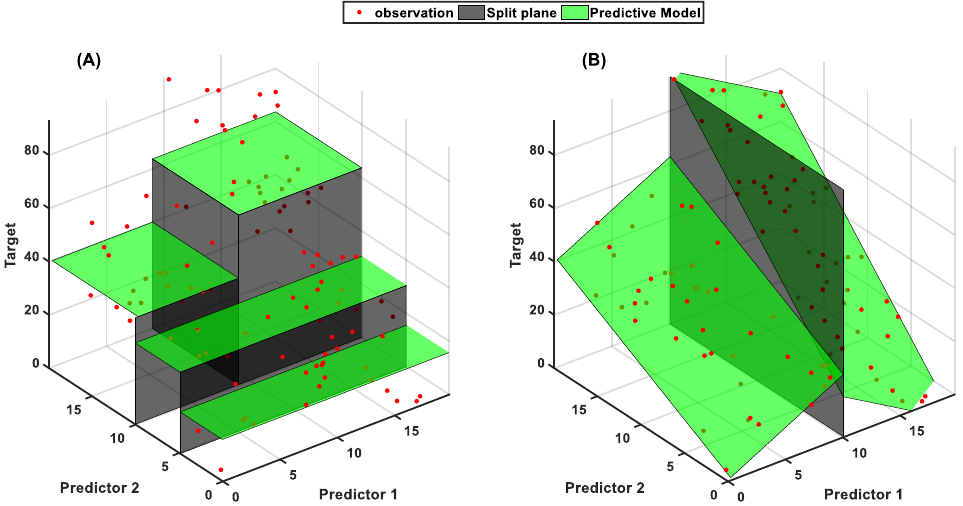
Figure 3. A comparison between the SSRM setting with single constant values in the terminal nodes (plot A ) and the SSRML setting with multiple linear regression in the terminal nodes (plot B ) for generating models with the MTG